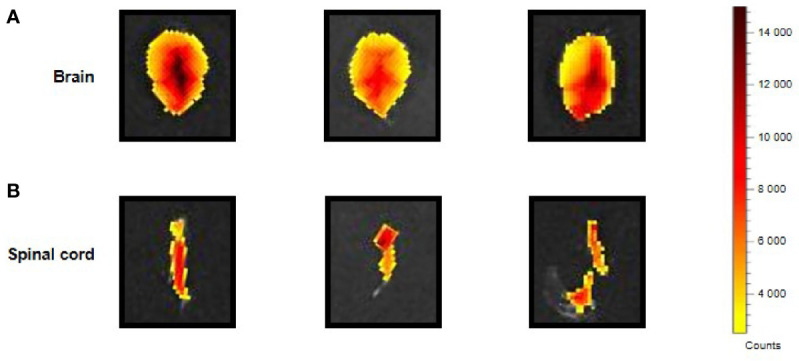
CNS distribution of the Cy5-labeled ERα17p peptide. Upper views of brain (A) and spinal cord (B) sampled from three mice 30 min after an i.p. injection of H2N-ERα17p-Pra(Cy5)-COOH (2 mg/kg).